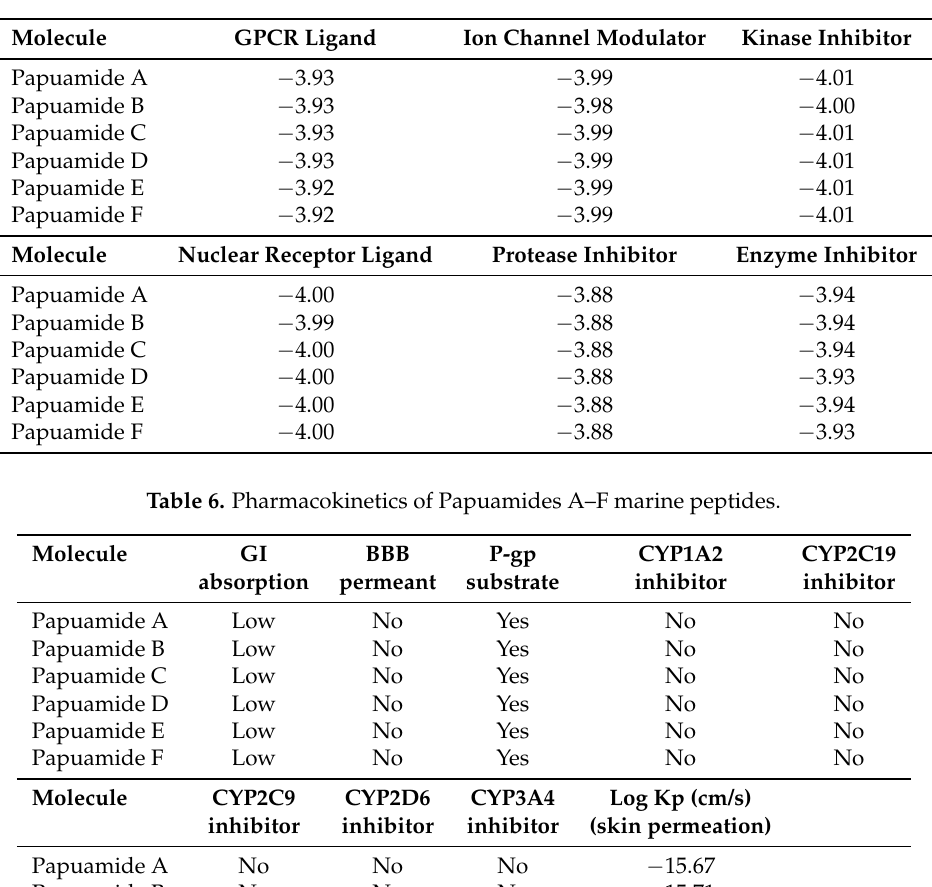
Table 5. Bioactivity scores of Papuamides A–F calculated on the basis of GPCR Ligand, Ion Channel Modulator, Nuclear Receptor Ligand, Kinase Inhibitor, Protease Inhibitor and Enzyme Inhibitor interactions.